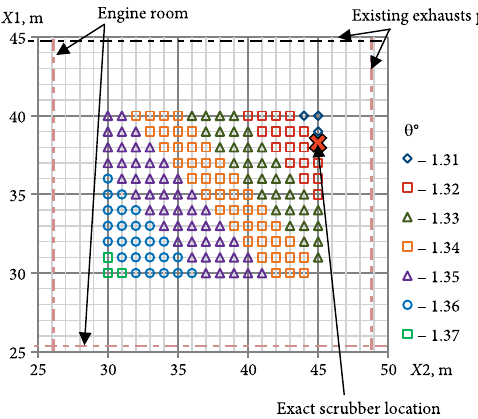
Fig. 10. The deviation of trimming angle depending on the displacement of block 1 and 2 on X axis